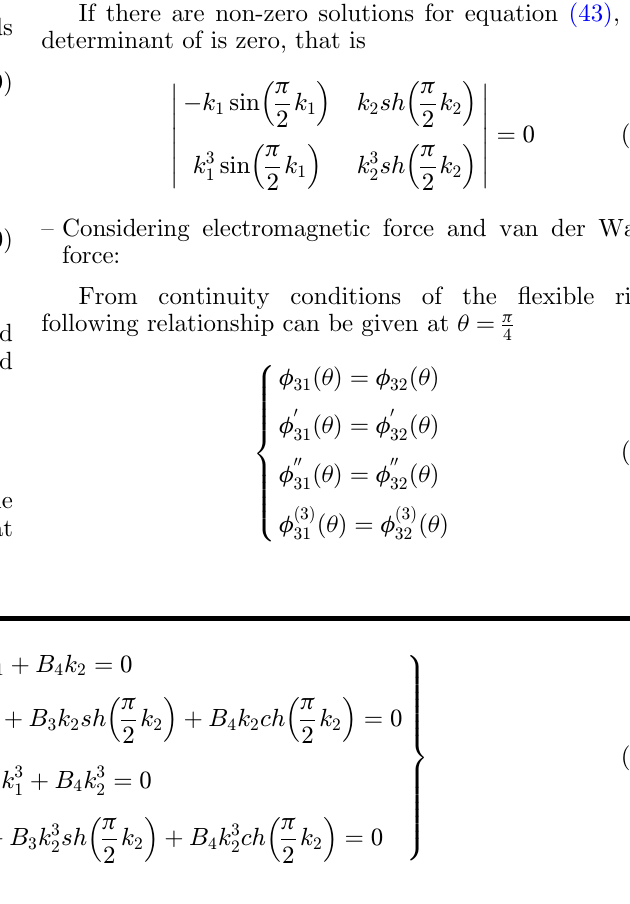
ffiffiffiffiffiffiffiffiffiffiffiffi p p 1 (cid:1) R